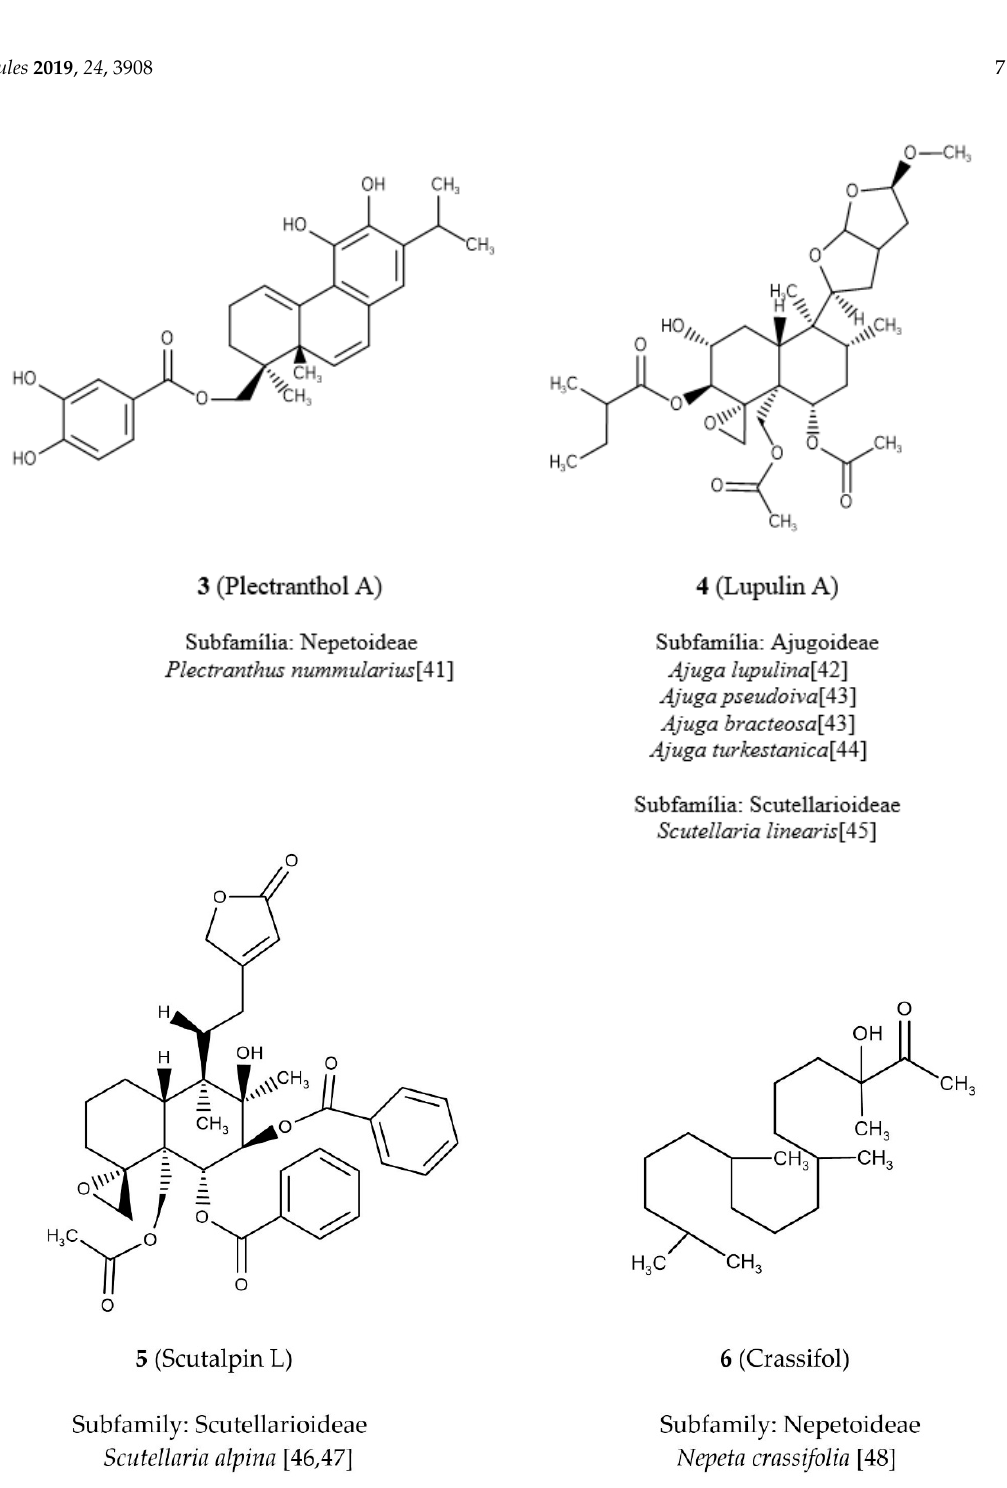
Figure 3. Chemical structures of the diterpenes located in the SOM of clade III (Nep) and clade IV (Aju, Lam, Scu) and their respective botanical occurrences.